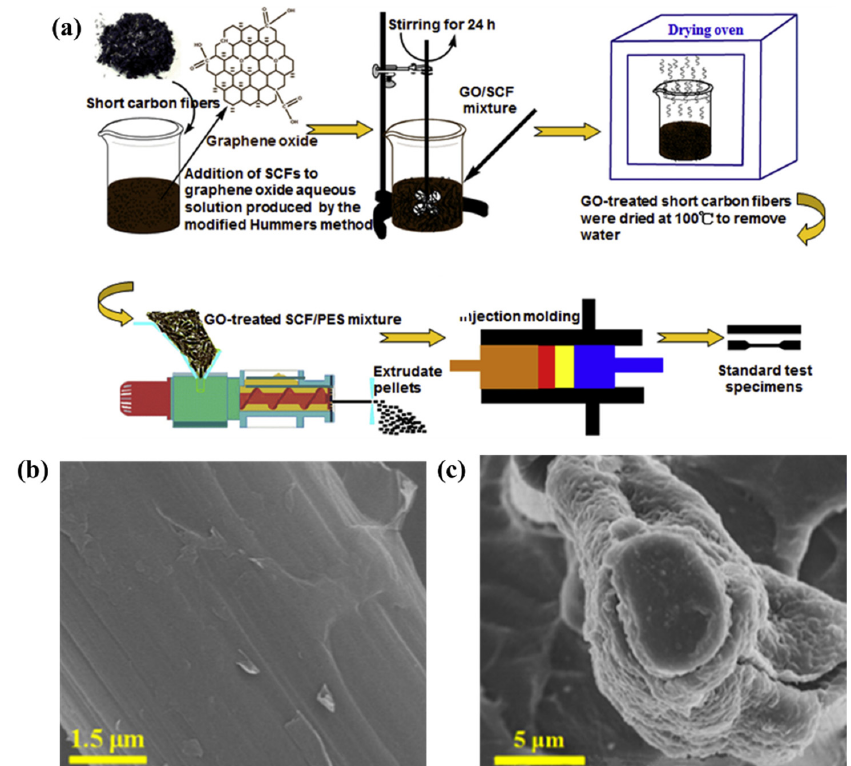
Figure 11. ( a ) Schematic of GO sizing onto short carbon fibers and the process chart of preparing GO-coated SCFs composite specimens. Reused with permission from Ref. [128]. Copyright 2015 Elsevier. ( b ) The SEM image of the GO-coated carbon fibers with the 0.5 wt% GO, ( c ) The SEM images of the tensile failure surfaces of 0.5 wt% GO-coated SCF/PES composite at 77 K. Reused with permission from Ref. [129]. Copyright 2016 Elsevier.